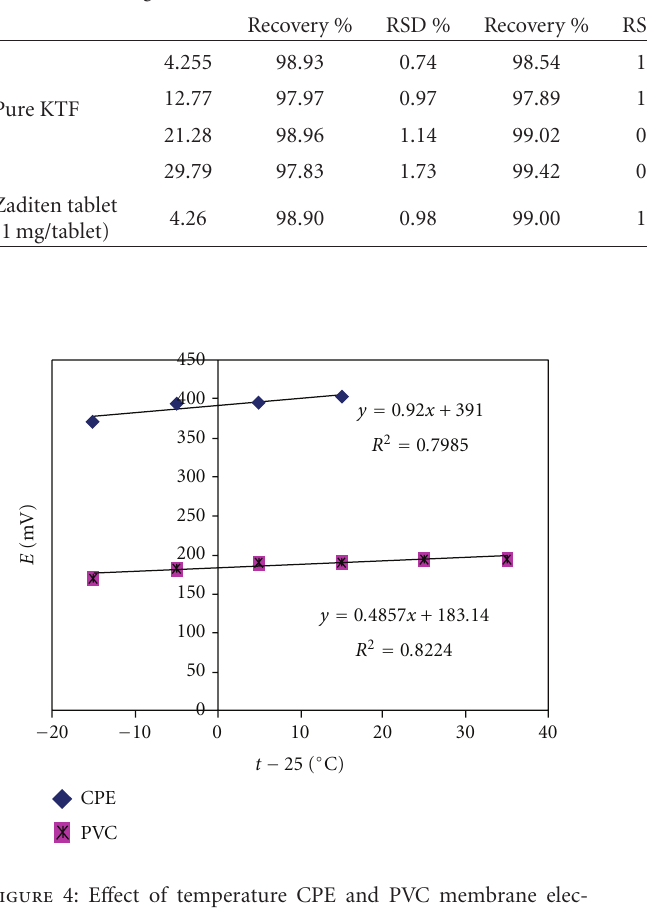
Table 3: Determination of ketotifen fumarate in pure solutions and pharmaceutical preparations using CPE and PVC sensors. CPE PVC Taken (mg) Direct method